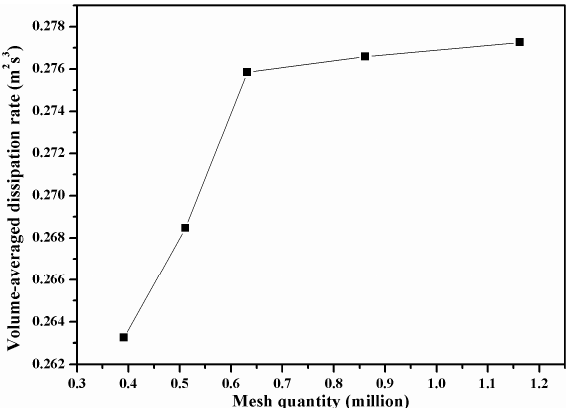
Figure 2. Volume-averaged turbulence dissipation rate for different mesh quantities.